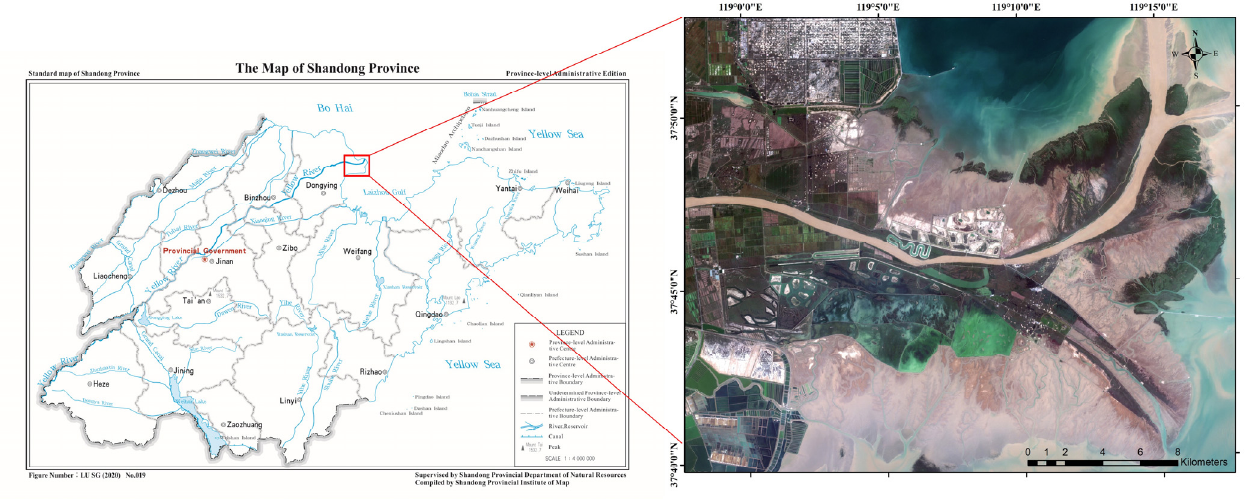
Figure 1. Location of study area in Shandong Province of China. The image to the right is a true color composite (red, green, blue bands) from Sentinel-2.